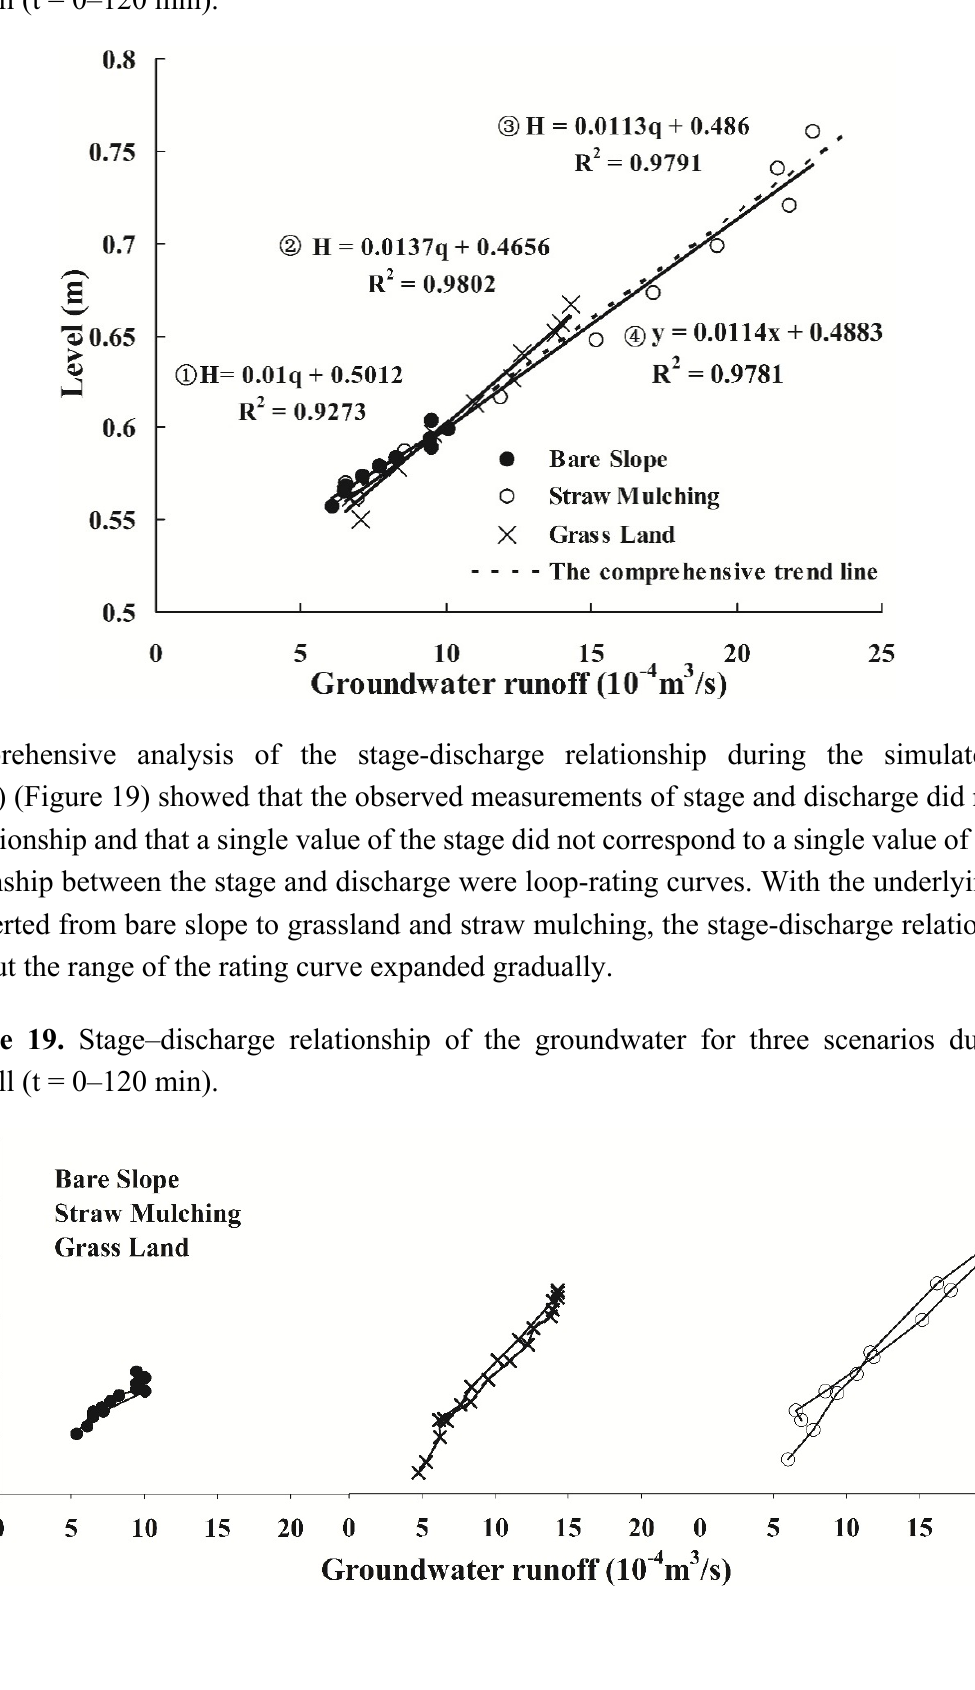
Figure 18. Stage-discharge relationship of the groundwater for three scenarios during rainfall (t = 0–120 min).